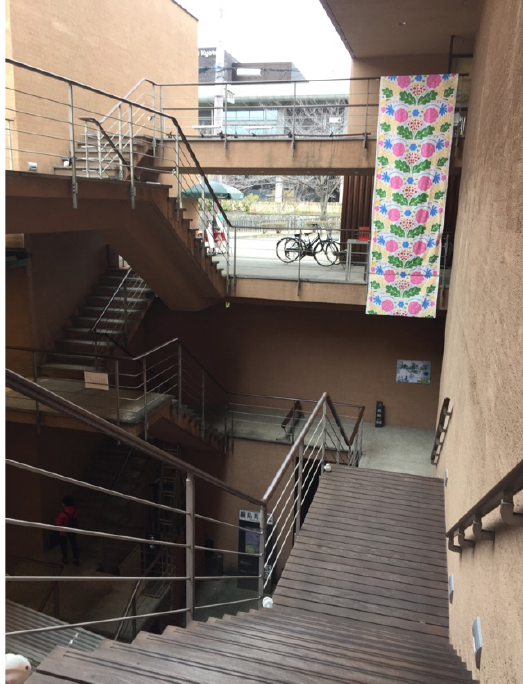
Fujiwo Ishimoto, Omni (Happiness), 1975. Installation view. Hosomi Museum, Kyoto, Japan. (photo: